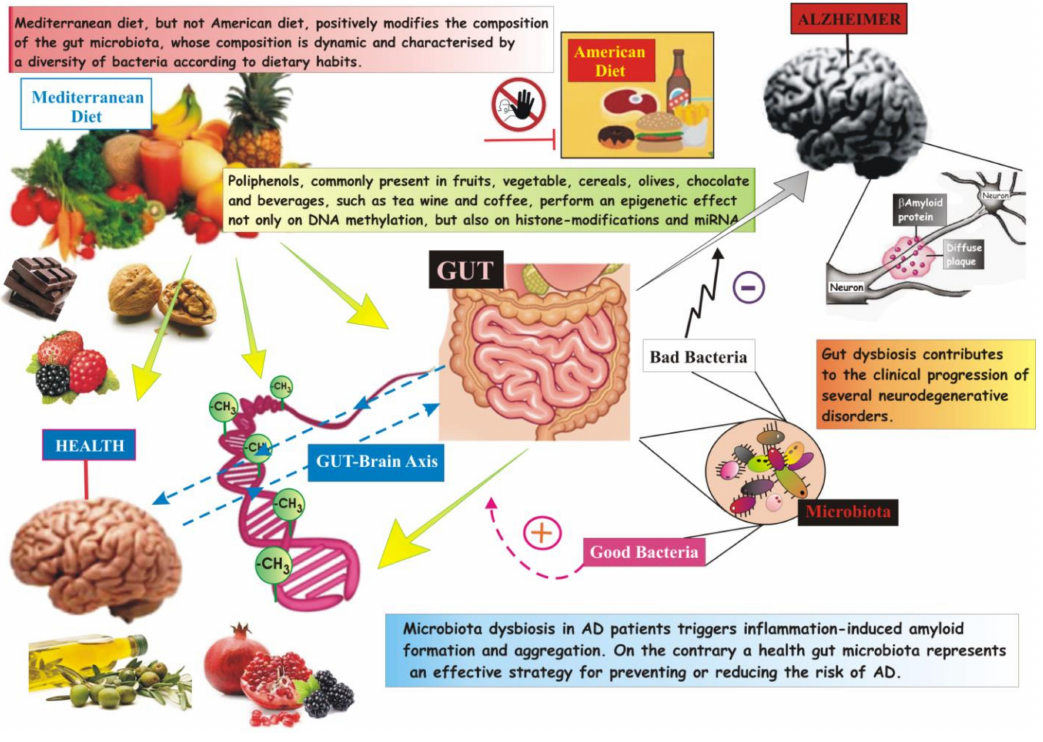
Figure 4. The picture describes that the Mediterranean diet, the richest diet in beneficial and highly nutraceutical substances in the world, may create putative links with microbiota and epigenetic mechanisms by modifying gut microbiota composition; thus, helping us to preserve our mental health, i.e., improve memory, cognitive functions, intelligence and sharpness, avoiding the risk of Alzheimer’s